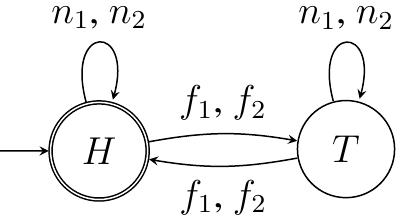
Figure 1. A simple example of a DFA ( i.e. , Deterministic Finite Automaton) that accepts sequences of moves of the simple coin game.